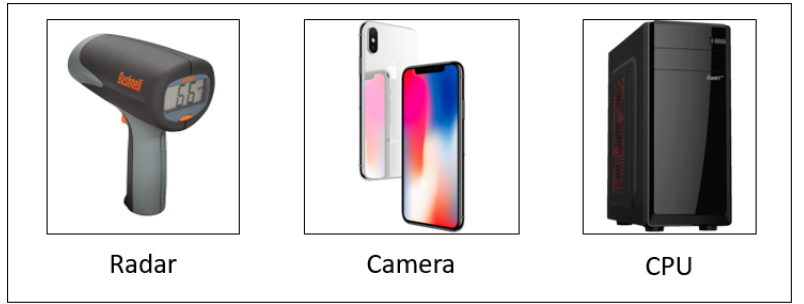
Figure 7. Components used to estimate the vehicle’s